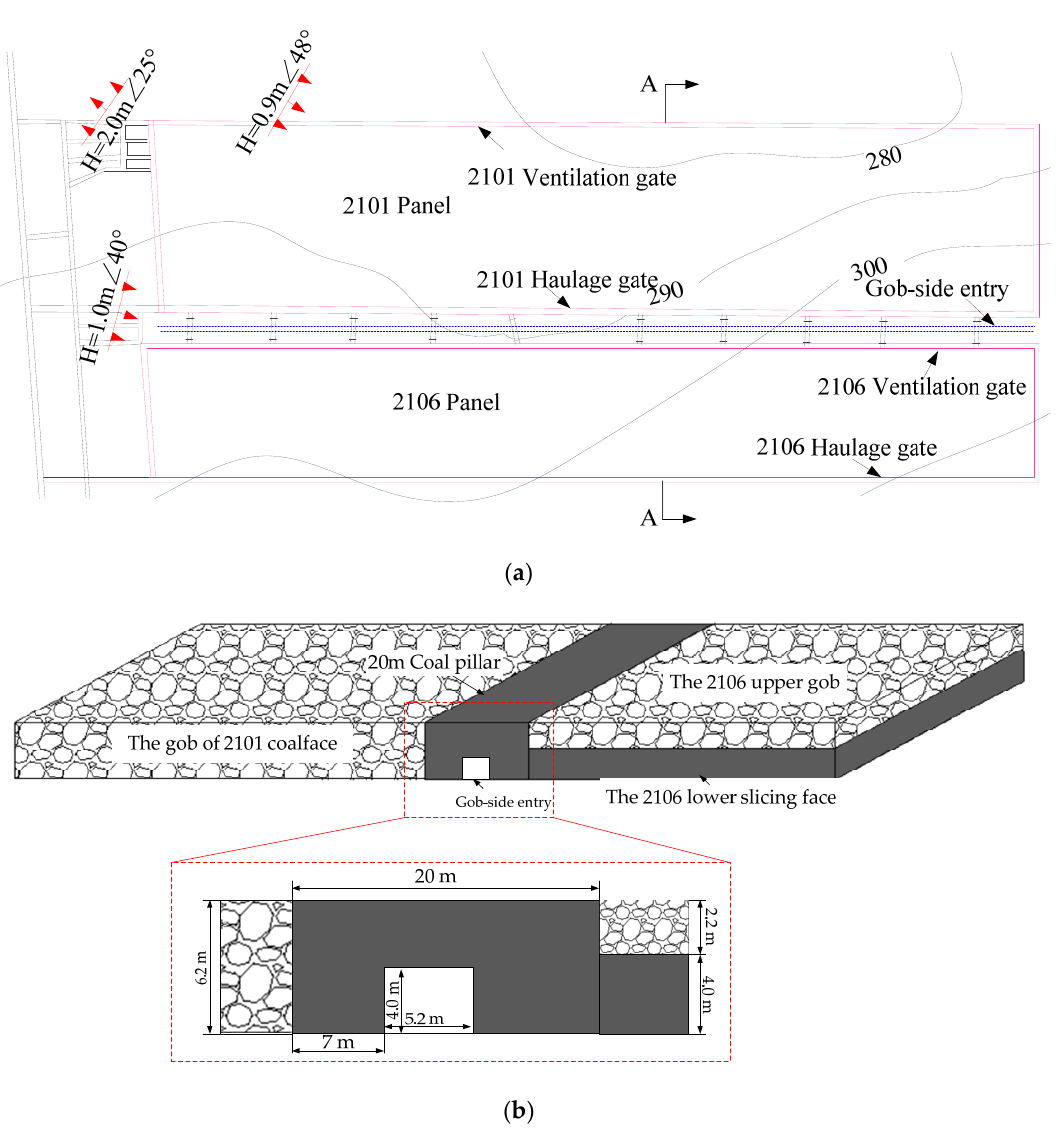
Figure 1. Layout of working face and gob-side entry. ( a ) Working face location plan; ( b ) A-A section